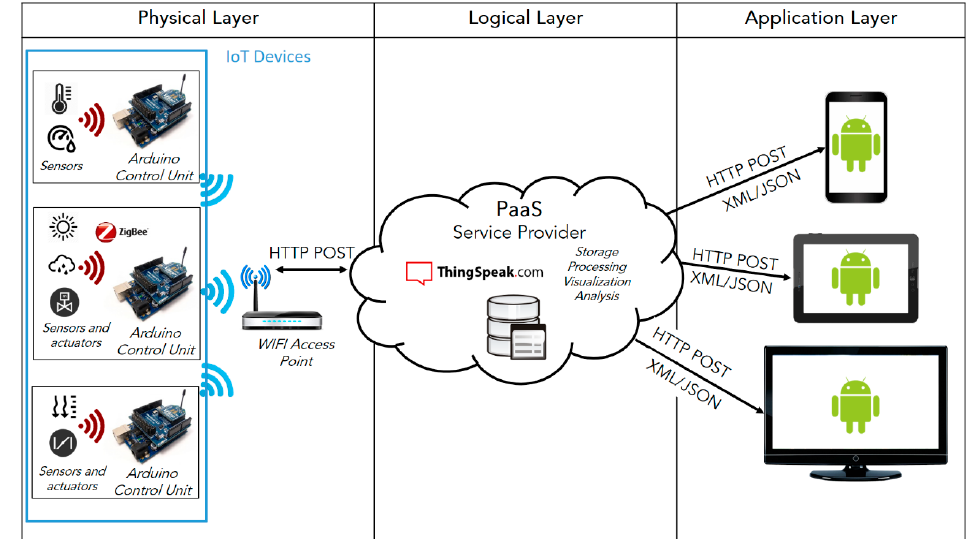
Figure 2. SmartResidents Architecture.